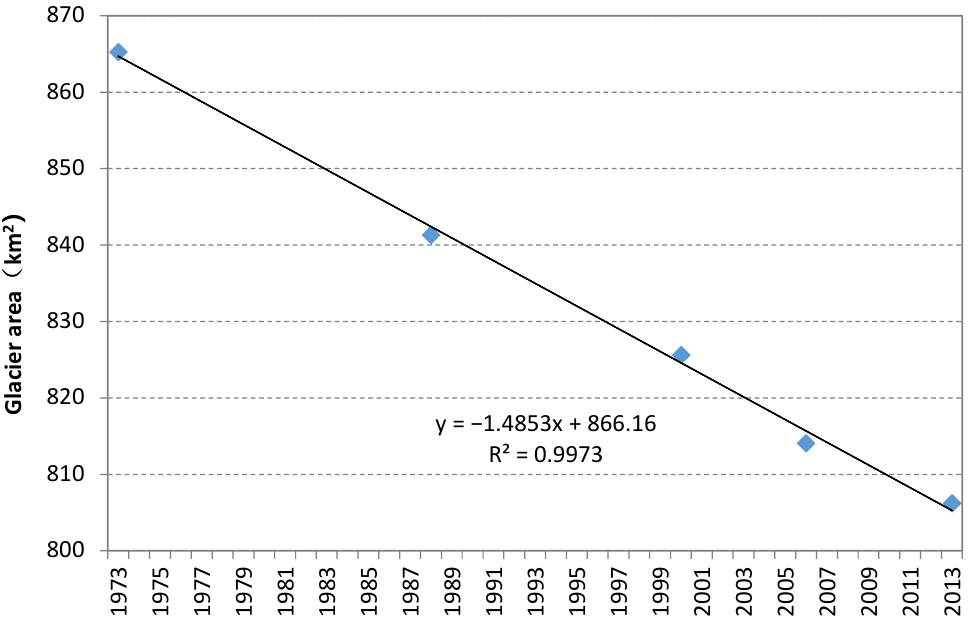
Figure 7. Changes of the glacial area in the Geladandong Peak region from 1973–2013.